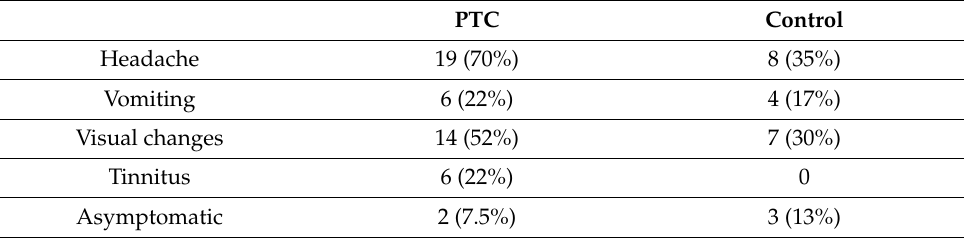
Table 2. Clinical presenting symptoms of the PTC and control